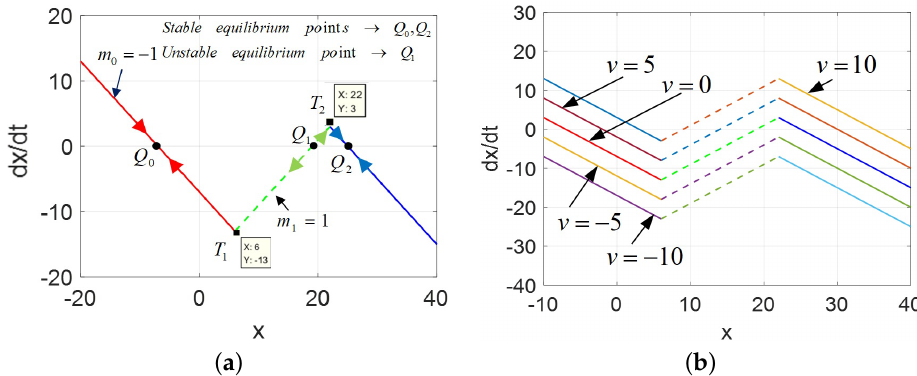
Figure 4. The DRM of 2-lobe CCM, A = A FS < A M : ( a ) DRM for the POP, v = 0; ( b ) DRM for v = 0,5,10.